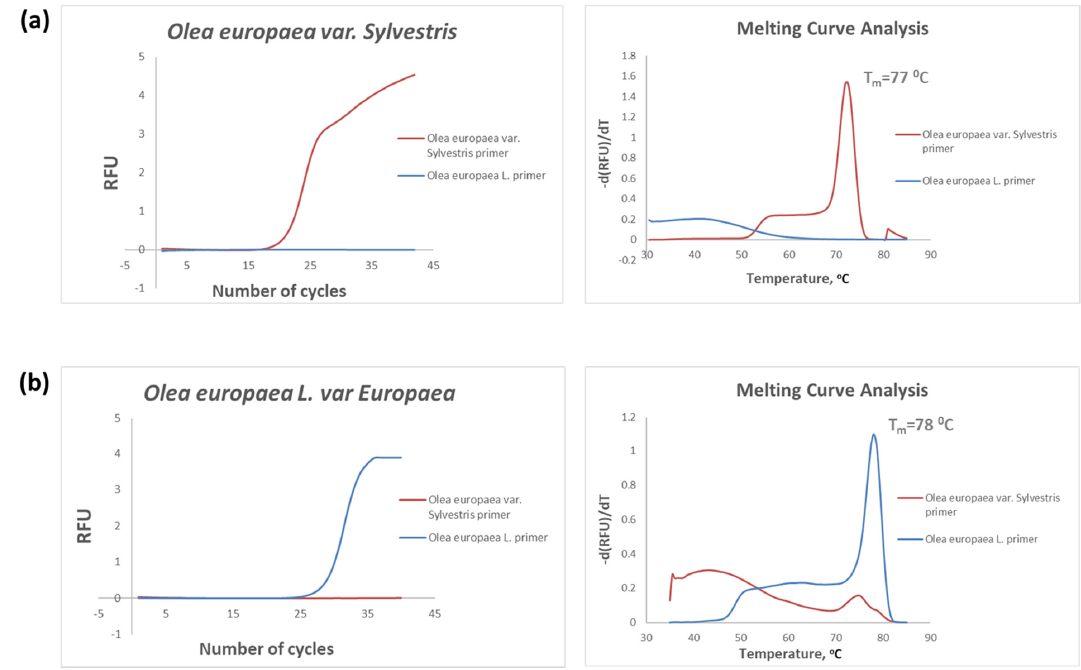
Figure 2. The real-time PCR curves, along with the corresponding melting curve analysis, obtained during the specificity study of the two-allele specific upstream primers with both DNA targets: Olea europaea var Sylvestris (wild-type of olive) ( a ) and Olea europaea L. var Europaea (cultivated olive) ( b ). Each specific primer strictly amplifies the fully complementary DNA sequence. T m : melting temperature, RFU: Relative Fluorescence Units.